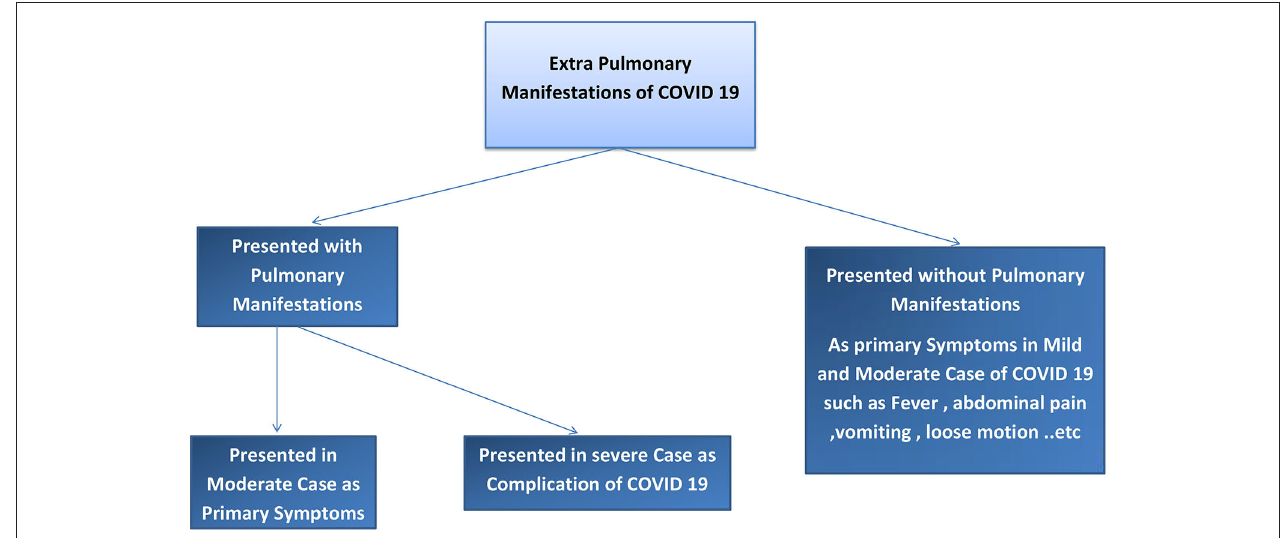
FIGURE 1 | Diagram to explain the presentation of extrapulmonary manifestations of COVID-19.